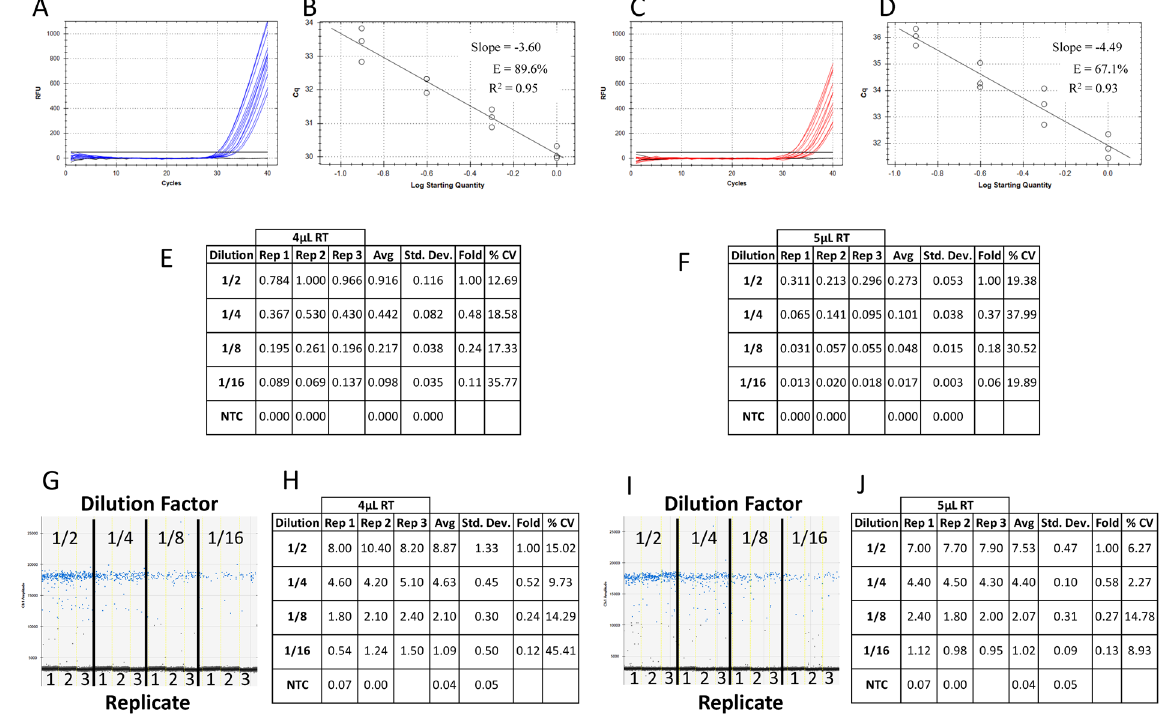
Figure 2. Effect of consistent sample contamination between identical DNA dilutions for ddPCR and qPCR technologies. Four reactions of 50 µ L were prepared in triplicate from 1/2 serial dilutions of synthetic DNA in a background of either 10 µ L ( A ) or 12.5 µ L ( B ) of 1X reverse transcription (RT) mix with primers and ddPCR EvaGreen supermix. Each reaction mix was split for quantification in qPCR and ddPCR (20 µ L for each platform containing either 4 µ L or 5 µ L of contaminating RT mix) and run on a single plate for each platform. Amplification traces ( A and C ), standard curves ( B and D ) and tabulated relative fold difference ( Δ Cq) results ( E and F ) were generated for qPCR. The ddPCR amplitude plots ( G and I ) and tabulated absolute concentration data ( H and J ) from the same reactions supplemented with 4 uL ( A,B,E,G,H ) and 5 uL ( C,D,F,I,J ) of RT mix were produced. NTC: No Template Control; Dilution: Dilution factor of DNA samples; Rep: Replicate number; Avg: Average of the replicates; Std. Dev.: Standard Deviation between the replicates; % CV: % Coefficient of Variance (Std. Dev./Avg *